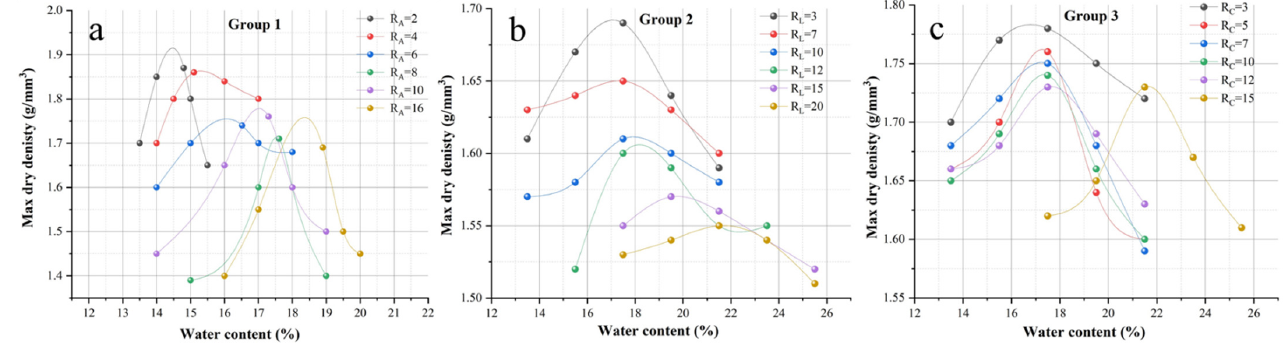
Figure 2. Compaction test results. (R—the percentage of material, A—attapulgite, L—lime, and C—cement). ( a ) Loess + Attapulgite, ( b ) Loess + Attapulgite + Lime, ( c ) Loess + Attapulgite + Ce- ment.